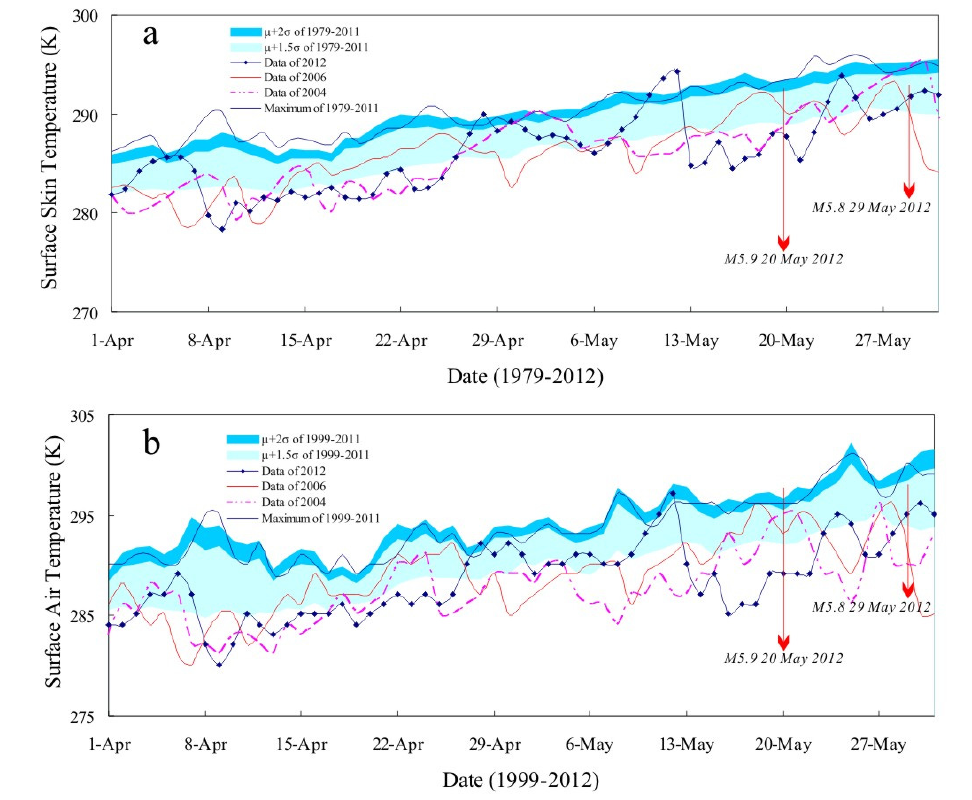
Figure 1. (a). The time series of surface skin temperature from MERRA for the area around the two major earthquakes epicenters (44.5 ˚N to 46 ˚N, 10.5 ˚E to 12 ˚E; red arrows indicate earthquakes time occurrences). (b). The time series of surface air temperatures from the weather ground station of Bologna (44.53 ˚N, 11.3 ˚E), close to the